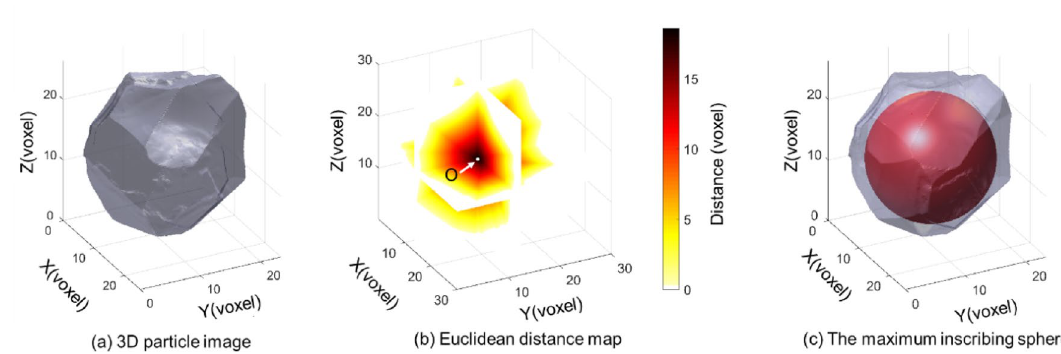
Fig. 7 Euclidean distance transformation for determining the maximum inscribing sphere